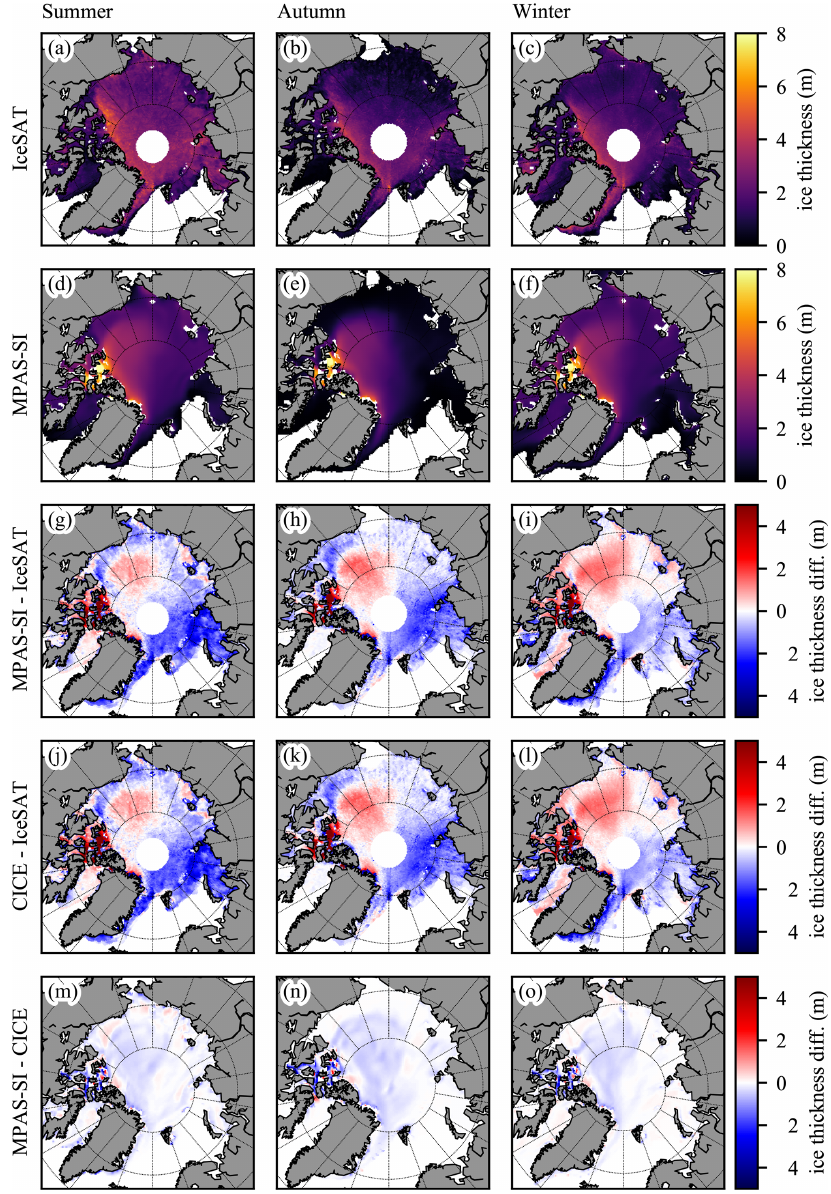
Figure 20. Spatial climatological maps of sea-ice thickness from ICESat (a–c) and MPAS-Seaice (d–f) . Differences between (g–i) MPAS- Seaice and (j–l) CICE ice thickness and ICESat observations. (m–o) Differences between MPAS-Seaice and CICE ice thickness. (a, d, g, j, m) Northern Hemisphere summer. (b, e, h, k, n) Northern Hemisphere autumn. (c, f, i, l, o) Northern Hemisphere